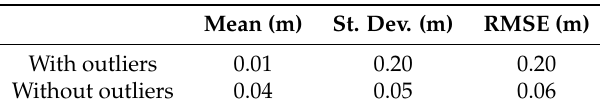
Table 5. Statistics of the differences between UAS and manual measurements in 2017. Results are reported with or without outliers (8 samples out of